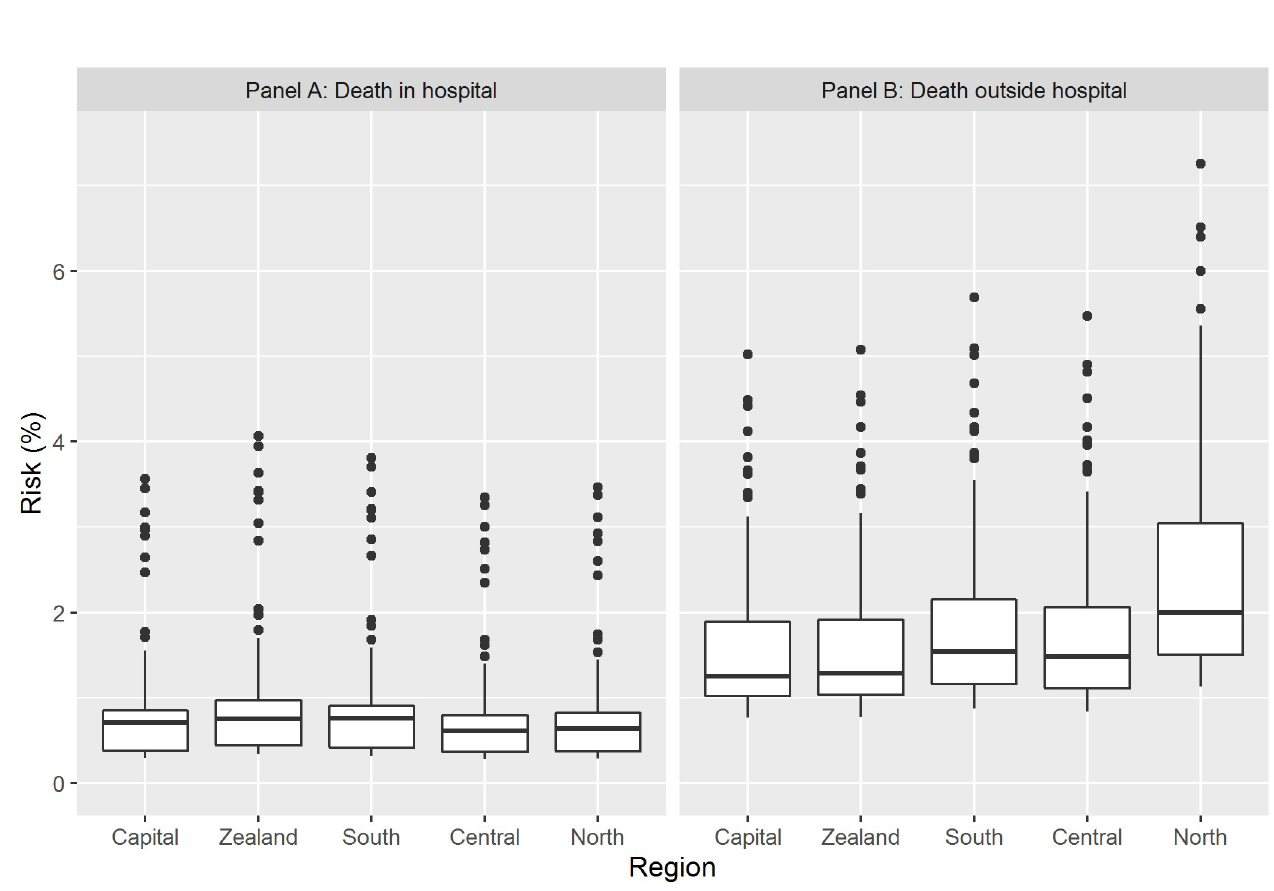
Fig 4. Absolute risk of fatal acute myocardial infarction stratified by region and place of death. Predicted absolute risk of fatal acute myocardial infarction (AMI), stratified by region and by place of death (Panel A: Death in hospital; Panel B: Death outside hospital). Boxplots show 5%, 25%, 50%, 75%, and 95% quantiles of differences in predicted absolute